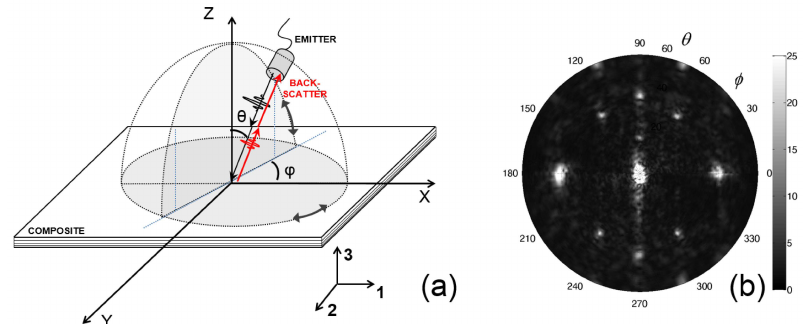
Figure 8. Schematic of ultrasonic backscatter polar scan (UBPS) method ( a ) and harmonic ultrasonic backscatter polar scan (H-UBPS) recording for a [0 ˝ ] 8 C/E laminate ( b